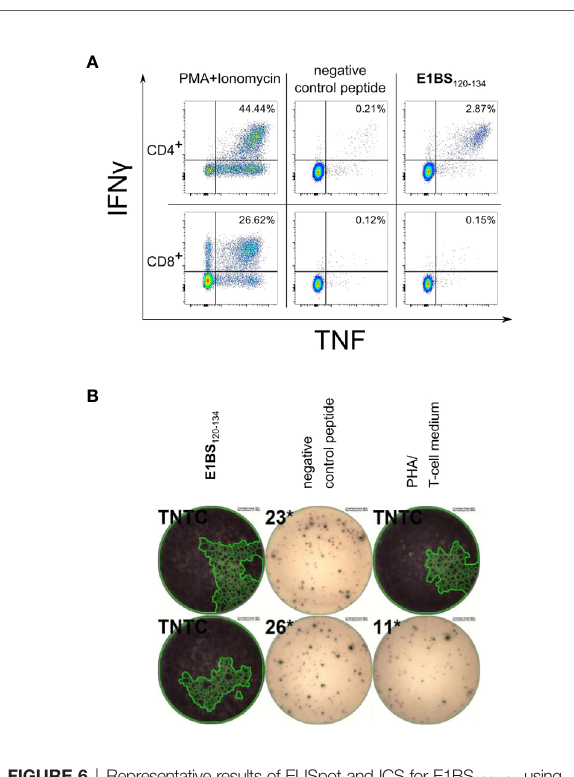
FIGURE 6 | Representative results of ELISpot and ICS for E1BS 120-134 using PBMCs of donor 2494. PBMCs of healthy blood donor 2494 were pre-stimulated with peptide and IL-2 for 12 days before ELISpot assay and ICS. PBMCs were gated on lymphocytes, single cells, viable cells, parallel on CD4 or CD8, and on IFN g and TNF in ICS. (A) ICS results of the HAdV-derived epitope E1BS 120-134 . Upper plots are gated on CD4 + positive cells and lower plots on CD8 + cells. (B) ELISpot results of E1BS 120-134 in donor 2494 and the negative control peptide in duplicates. PHA, positive control. TNTC, too numerous to count.